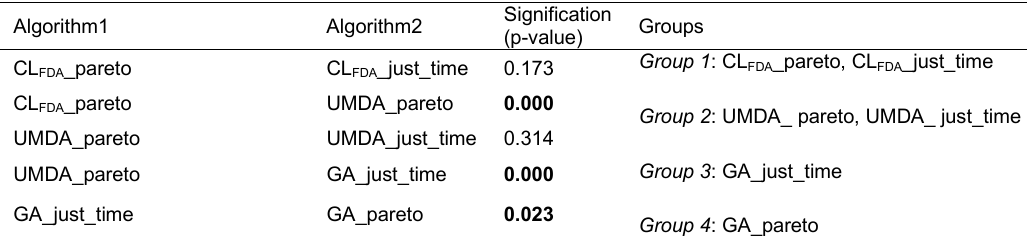
Table 14. Comparison results using Wilcoxon test, variable